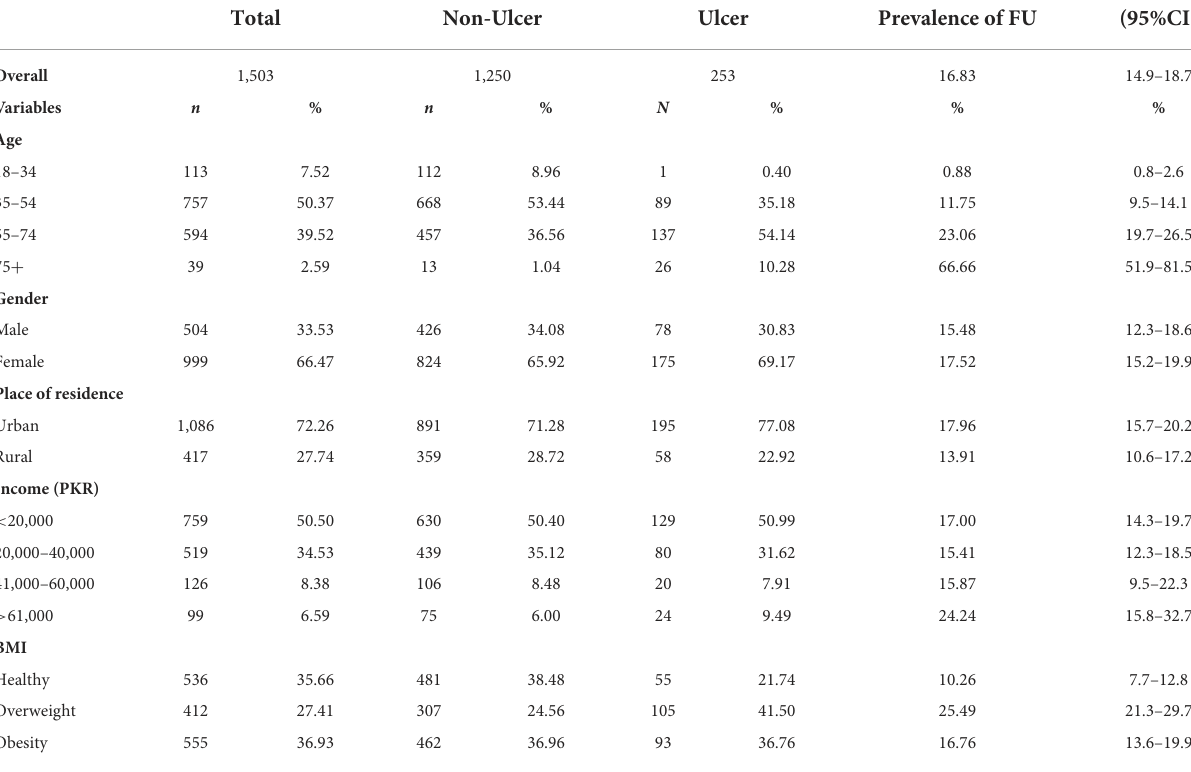
TABLE 2 Foot ulcer status by the study participants’ characteristics.